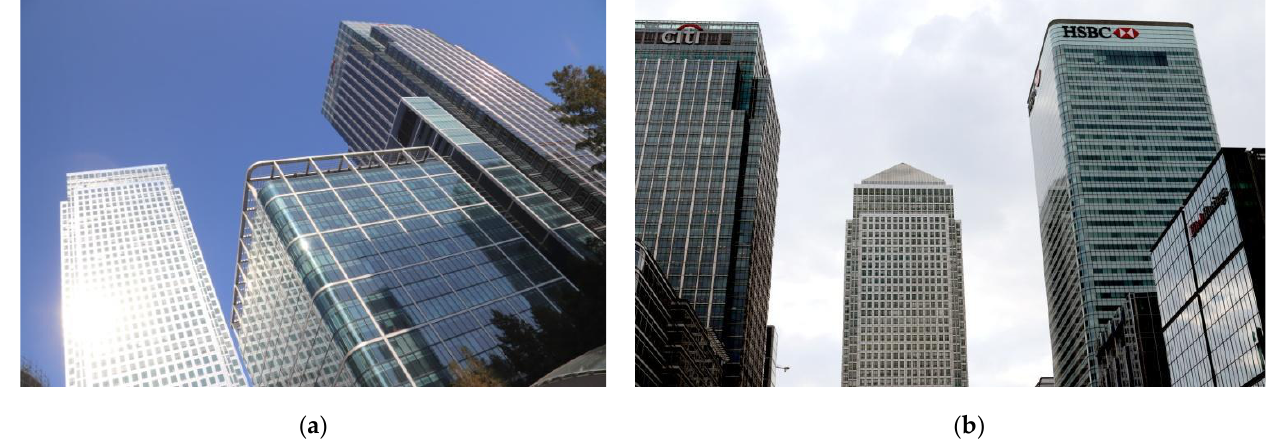
Figure 4. Change in appearance of the building depending on light conditions. ( a ) From the left: One Canada Square 25 Canada Square and 33 Canada Square in plain sunshine (2021); ( b ) From the left: 33 Canada Square, One Canada Square and 8 Canada Square office buildings in cloudy weather (2021).